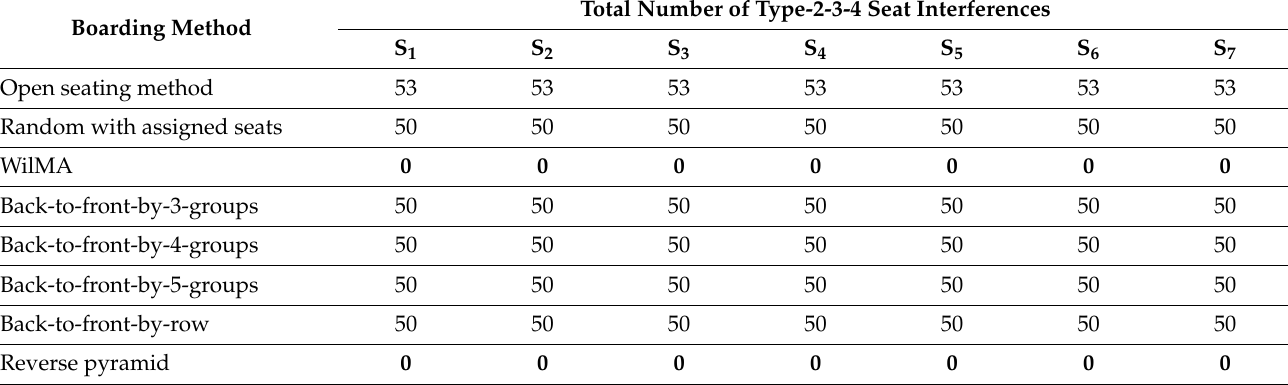
Table 7. Total number of type-2-3-4 seat